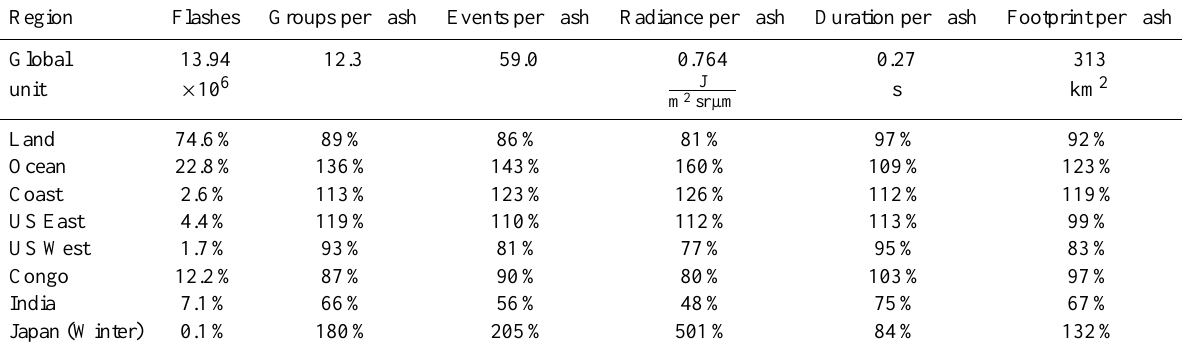
Table 3. As Table 2, but for LIS